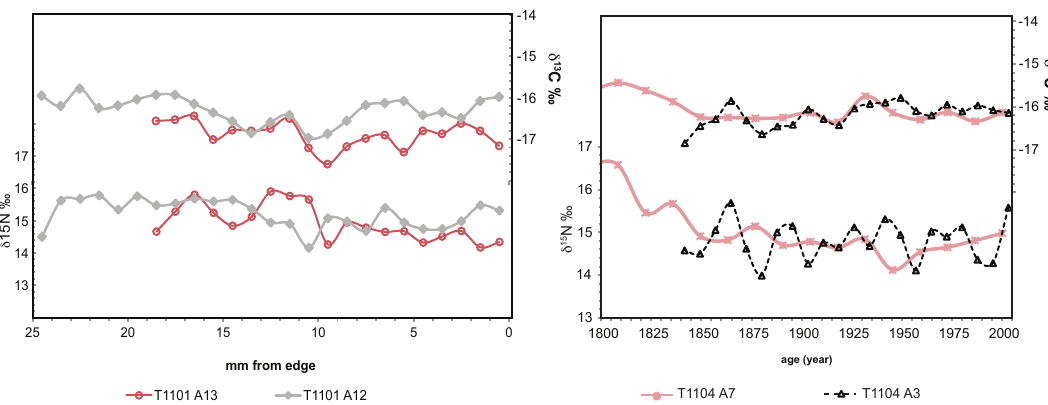
Figure 5. Intercolony isotopic comparison. (A) δ 15 N and δ 13 C values from two corals from Pioneer Seamount, plotted against sampling location (distance from edge), indicating intercology reproducibility of <1.5‰. These corals do not have D 14 C-based chronologies, so an assumption of equivalent growth rates is required and may introduce error in calculating reproducibility. (B) δ 15 N and δ 13 C values from two corals sampled from the same region (Monterey Canyon). Isotopic values plotted versus age, based upon extension rates established for each coral in Table 3. These data establish reproducibility of <0.5‰.